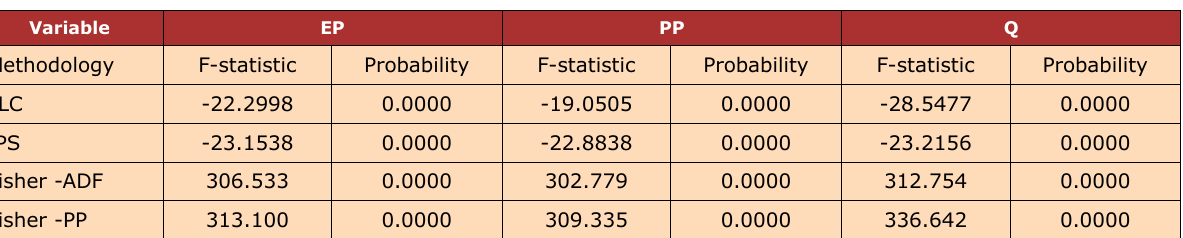
Table 3. Empirical results of unit root test of panel data (Q, EP, PP)